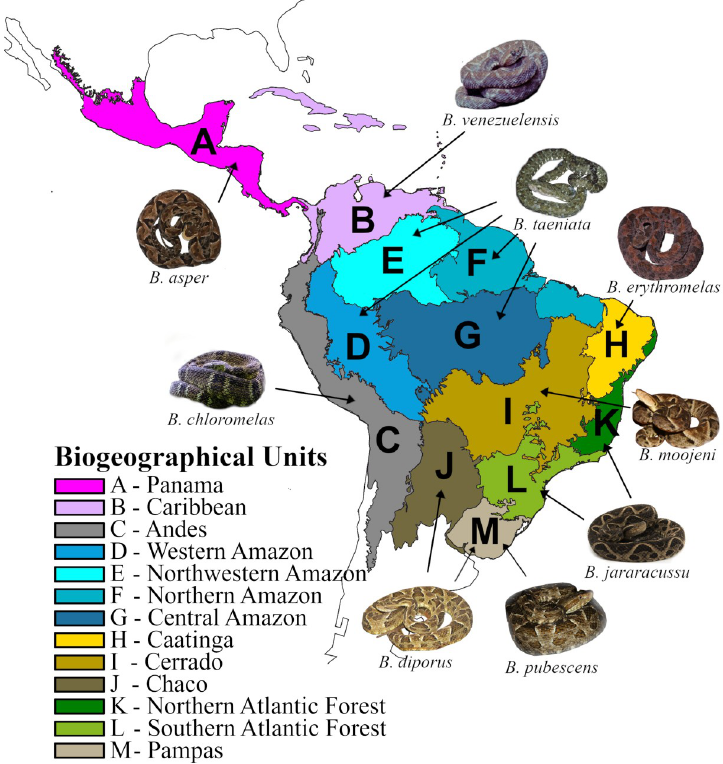
Fig 2. Regionalization scheme used in this study. Biogeographical units are indicated by capital letters. Ecoregions or combinations of more than one ecoregion followed Olson et al. [63] and Dinerstein et al. [64] and were based on the present geographic range of Bothrops species. Images of Bothrops species are examples of some key species in each biogeographic unit. Photograph credits: Bruno Ferreto Fiorillo ( Bothrops jararacussu ), Marcio Martins ( B . moojeni , B . diporus and B . erythromelas ), Laurie J. Vitt ( B . taeniata and B . venezuelensis ), Conrado Mario da Rosa ( B . pubescens ), Herpetolo´gica LAB from Mexico ( B . asper ), and Thibaud Aronson ( B . chloromelas ). Map source: Natural Earth (www.